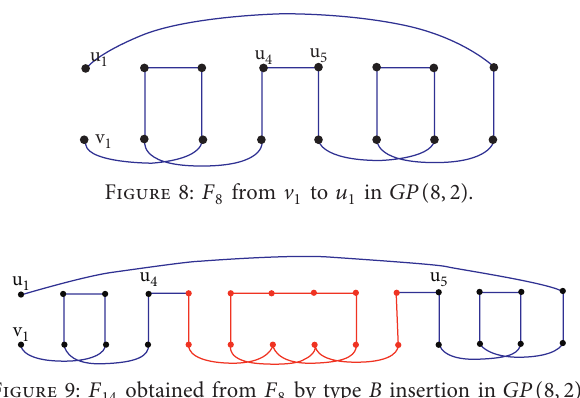
Figure 7: F obtained from F 14